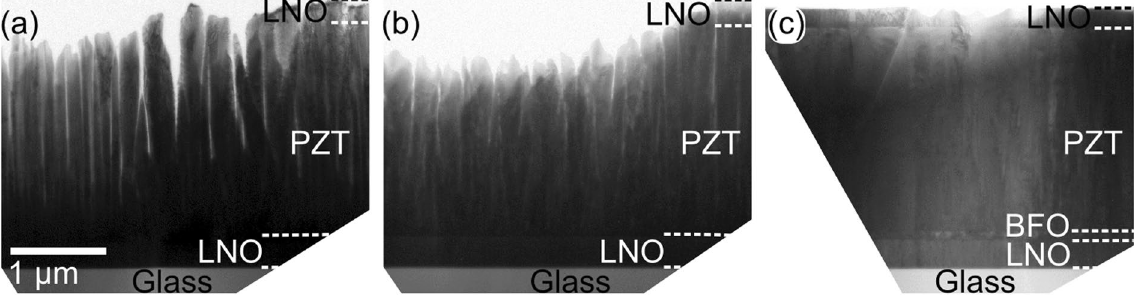
Figure 4. Cross-sectional TEM images revealing the impact of growth conditions on the heterostructures ( a ) H 20Hz , ( b ) H 5Hz , and ( c ) H BFO .